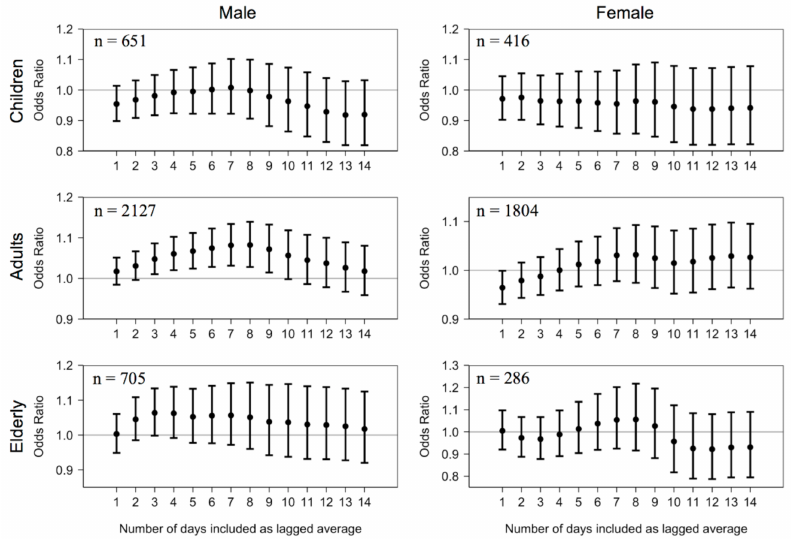
Figure 3. Adjusted odds ratios for the daily number of asthma patients treated with nebulized medication in relation to a 1 ◦ C decrease in daily mean temperature. Vertical lines denote the 95% confidence intervals. Temperature lags up to the previous two weeks are constrained as